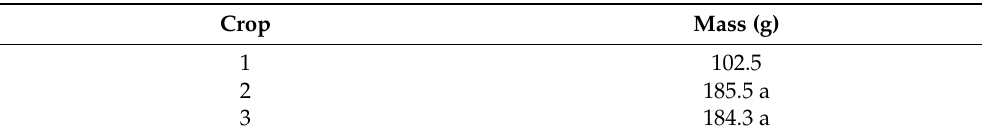
( b ) ( c ) Figure 12. Leaf thermal image capture samples (IR): ( a ) two days before water stress, ( b ) on the day when water stress occurred and ( c ) two days after the water stress. Table 5. Average temperatures obtained during the water stress period. Average Temperature of (°C)